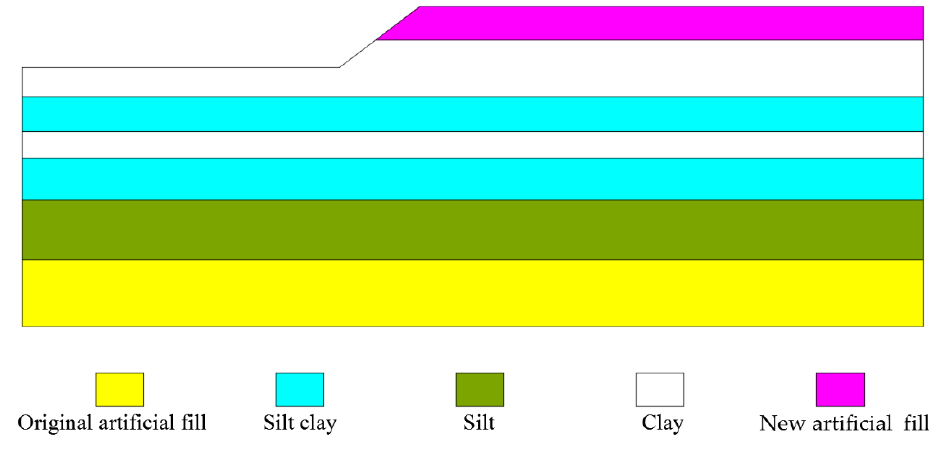
Figure 4. The section of material of the riverbank slope’s soil. Table 1. The material properties of the riverbank slope’s soil, anti-slide piles and geocells.